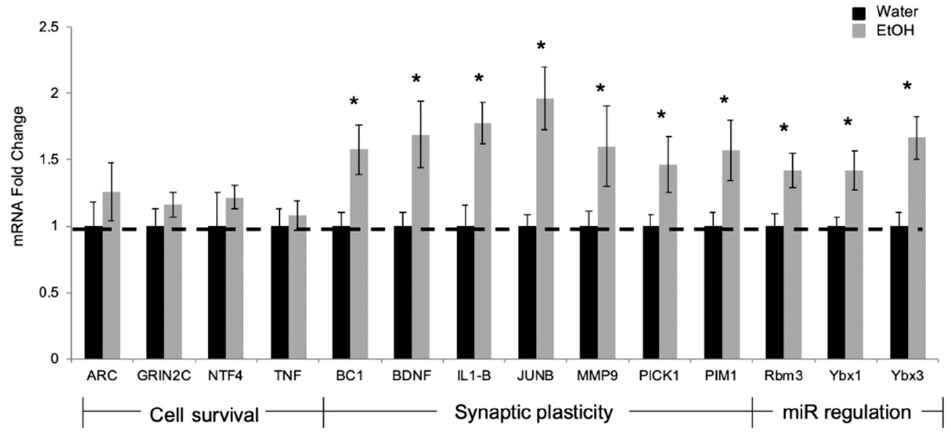
Figure 5. Ethanol treatment during peri-puberty alters mRNA expression at PND 44. Effects of repeated binge-pattern EtOH exposure on mRNA levels in the ventral hippocampus of male rats at PND 44 following repeated binge-pattern EtOH administration paradigm during peri-puberty. Genes grouped by function, listed below the X-axis. Data analyzed by ∆∆ Ct method and depicted as mean ± SEM. N = 10/group, an (*) indicates p < 0.05.